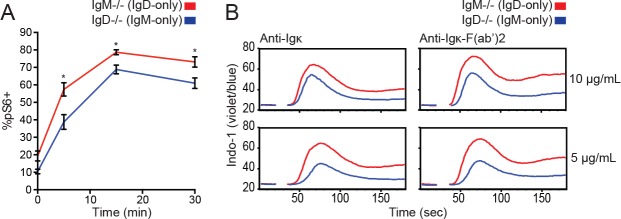
S6 and calcium signaling in IgM-/- and IgD-/- B cells.(A) S6 phosphorylation kinetics in splenic CD23+ B cells following stimulation with 15 μg/mL anti-Igκ. (B) Splenocytes from IgM−/− and IgD−/− mice were loaded with Indo-1 and stimulated with 10 or 5 μg/mL anti-Igκ or anti-Igκ F(ab’)2. Data in (A) and (B) are representative of n = 3 and n = 2 independent experiments, respectively. Welch’s t test was used to calculate p values, and mean ±SEM is displayed. *p<0.05.